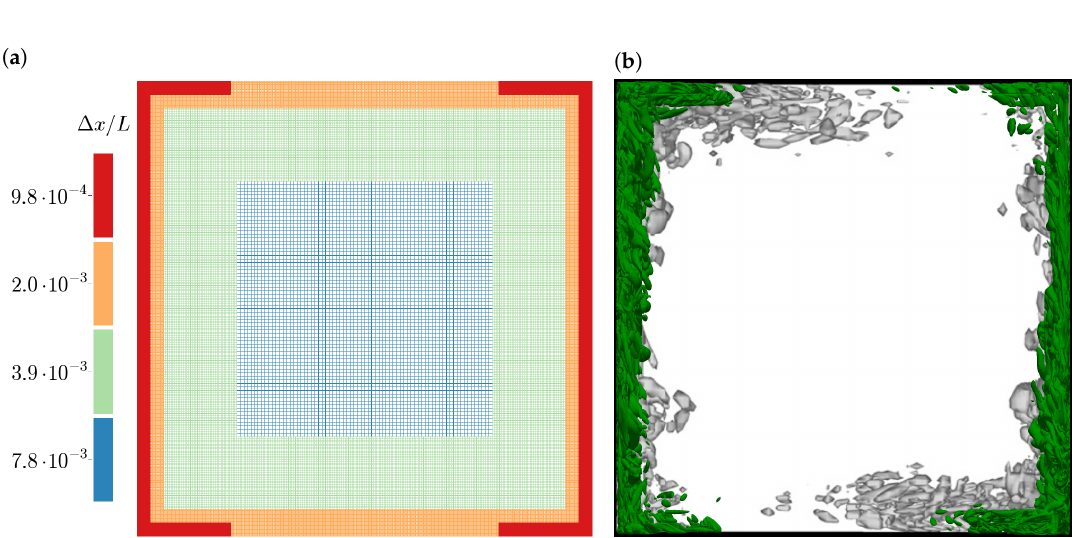
Figure 4. 3D square cavity: ( a ) Non-uniform grid for the GKS simulations with four levels. ( b ) Contour of the Q criterion at Q = 3 U 0 . Grey contour: simulation by Salinas-Vázquez et al. [72]; green Contour: present GKS simulation; the grey contour shows additional turbulence at the top and bottom walls, which is not seen in the present